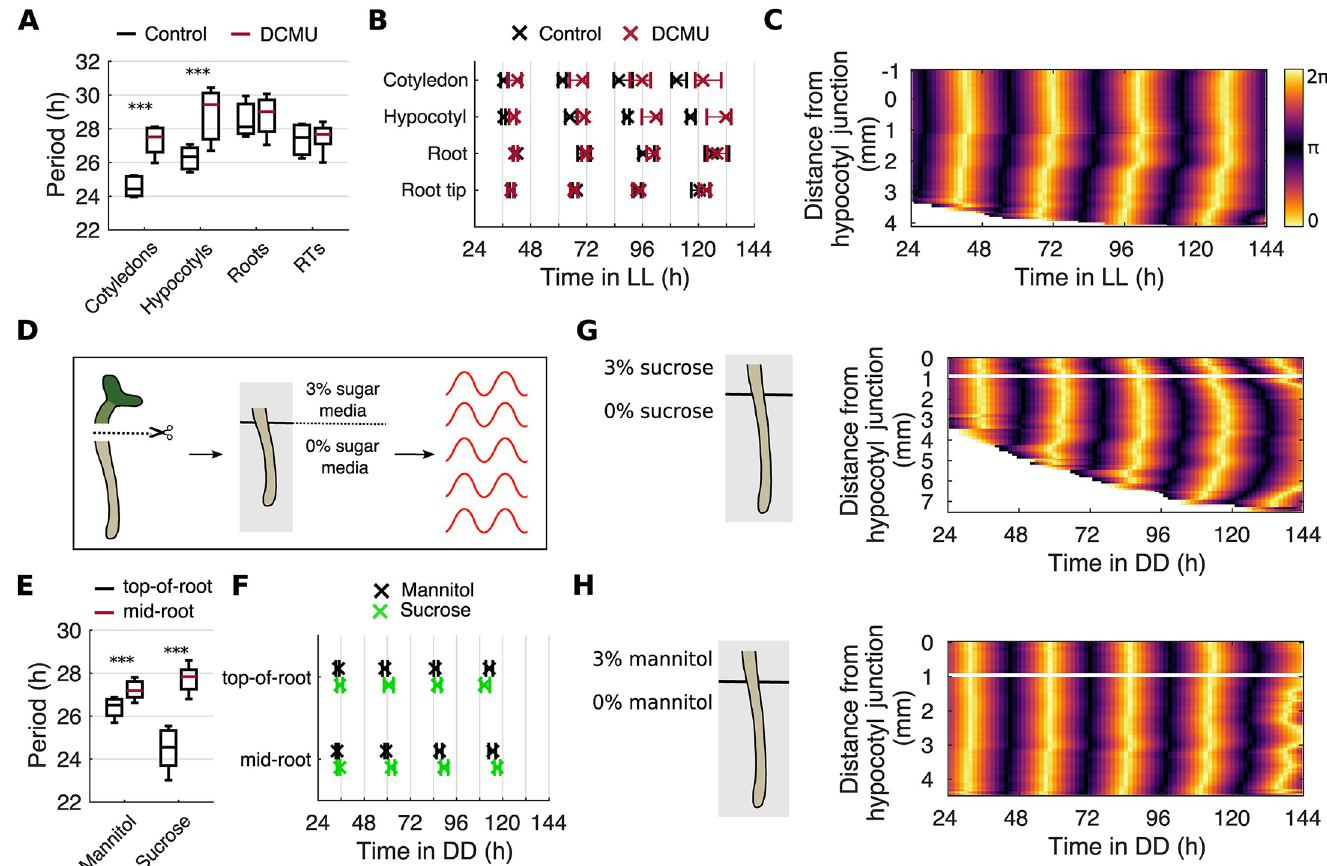
Fig 7. Photosynthetic sugar can drive spatial waves of clock gene expression by altering periods locally. (A) Period estimates of GI :: LUC for different organs during the inhibition of photosynthesis by DCMU. ��� p < 0.001, by two-tailed t test, Welch correction. (B) Times of peaks of of GI :: LUC expression in different organs during the inhibition of photosynthesis by DCMU. Color legend is as in A. Plots represent the 25th percentile, median, and the 75th percentile for the peak times of organs scored as rhythmic. (C) Representative phase plot of GI :: LUC expression across longitudinal sections of the hypocotyl and root of a single seedling during the inhibition of photosynthesis by DCMU. (D) Schematic representing the experimental design. Seedlings are cut at the hypocotyl junction and the excised root laid across two adjacent agar pads, one containing sugar-supplemented media and the other not, so that only the top part of the root is in contact with sugar. Roots are then imaged under DD. (E) Period estimates of GI :: LUC for the top and middle regions of the root during the partial contact of the root with sucrose or mannitol, under DD. ��� p < 0.001, by two-tailed t test, Welch correction. (F) Times of peaks of GI :: LUC expression for the top and middle regions of the root during the partial contact of the root with exogenous sucrose or mannitol, under DD. Plots represent the 25th percentile, median, and the 75th percentile for the peak times of organs scored as rhythmic. (G, H) Representative phase plot of GI :: LUC expression across longitudinal sections of the hypocotyl and root of a single seedling during the partial contact of the root with exogenous sucrose (G) or mannitol (H), under DD. Schematic shows the approximate position of the root on the agar pads. Color bars are as in C. For DCMU, N = 3; exogenous sucrose, N = 3; exogenous mannitol, N = 2. For all, n = 8–30. N represents the number of independent experiments and n the total number of organs tracked. See S1 and S2 Files for exact n , test statistics, and percentage rhythmicity in each organ. Box plots indicate the median and upper and lower quartiles, and whiskers the 9th and 91st percentiles of organs scored as rhythmic. Underlying data are available from https://gitlab.com/slcu/teamJL/ greenwood_etal_2019. DCMU, 3-(3,4-dichlorophenyl)-1,1-dimethylurea; DD, constant darkness; GI , GIGANTEA ; LL, constant light; LUC , LUCIFERASE ; RT, root tip.